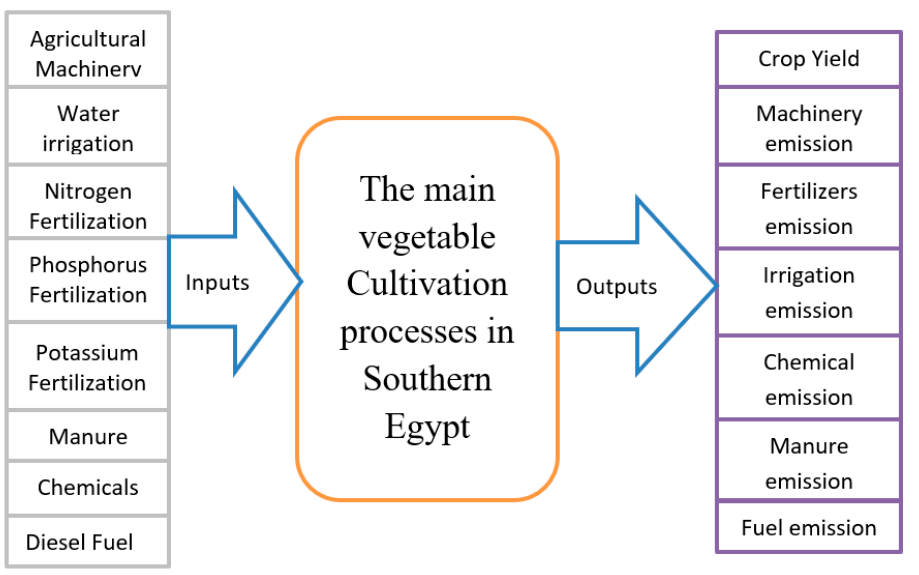
Table 1. Number of inputs and outputs of production processes for onion, potato and